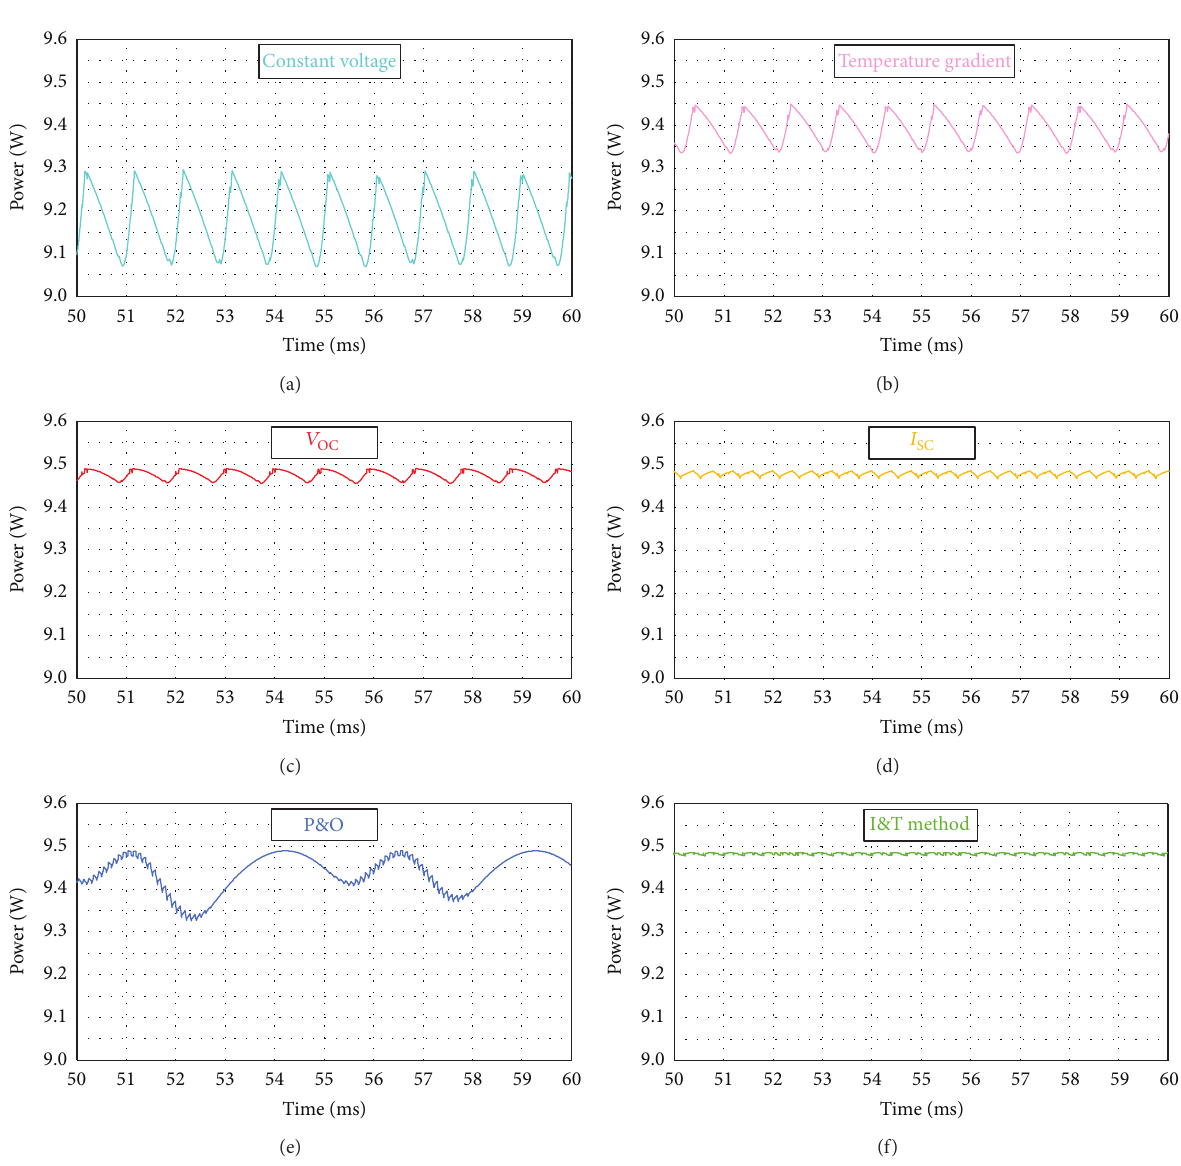
Figure 11: Steady-state behavior of MPPT techniques (1000W/m 2 , 45 ∘ C): (a) constant voltage; (b) temperature gradient; (c) open-circuit voltage; (d) short-circuit current; (e) P&O; (f)